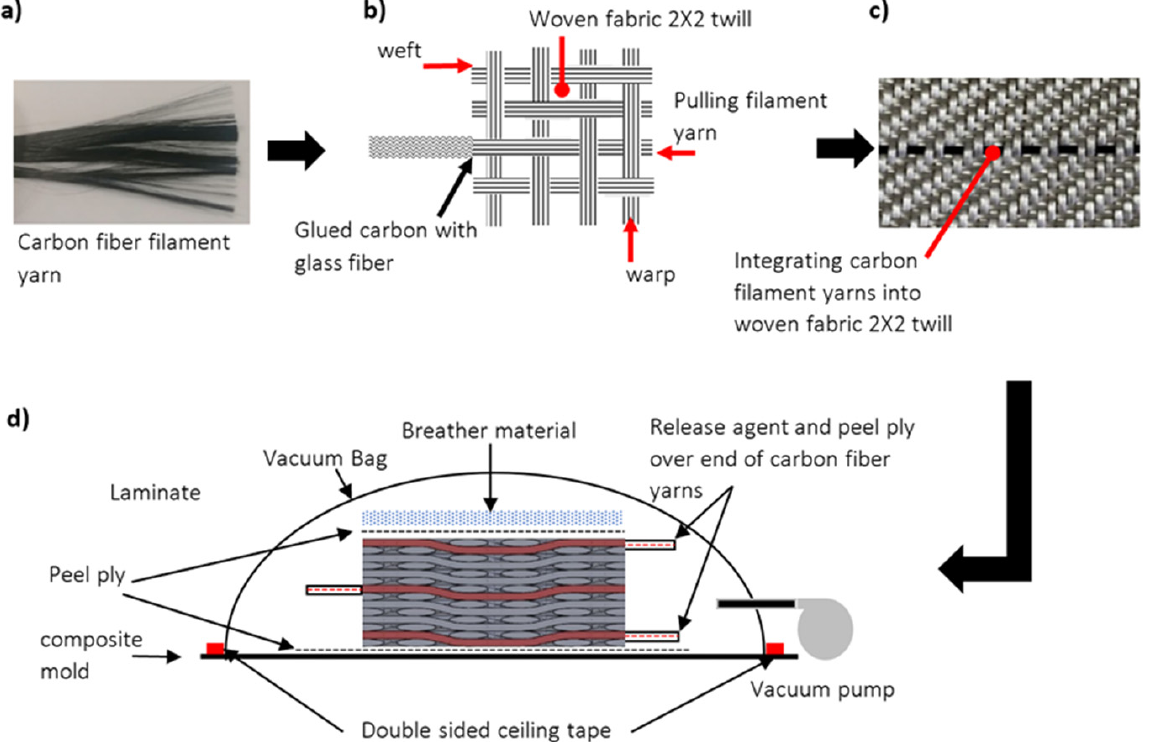
Figure 3. Fabrication process of the intra-ply hybrid fabric and capacitive sensor: ( a ) an image of continuous carbon fiber yarn, ( b ) schema showing the process of integrating continuous carbon fiber yarn into fiberglass woven fabric 2 × 2 twill 280 g/m 2 , ( c ) an image of the intra-ply hybrid fabric produced, and ( d ) schematic presentation of vacuum bagging